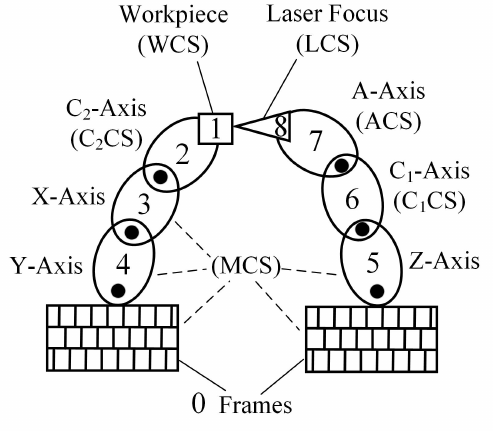
Figure 2. Kinematics chain diagram of multi-axis LEMT.